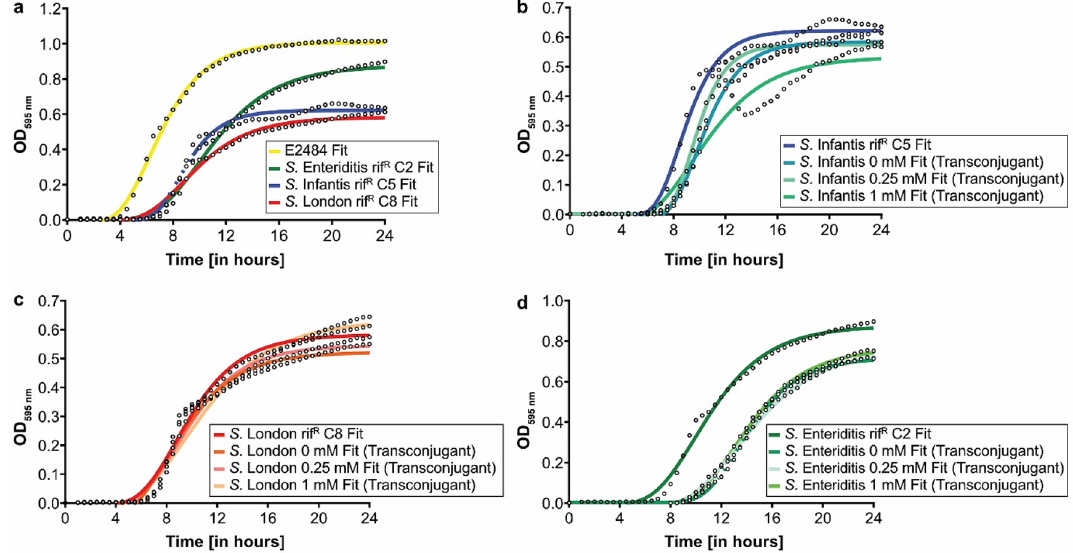
Figure 3. Gompertz-fitted growth curves of donor, recipients, and transconjugants with ( a ) comparisons of donor and recipient strain, ( b – d ) comparisons of transconjugants with their parent recipient